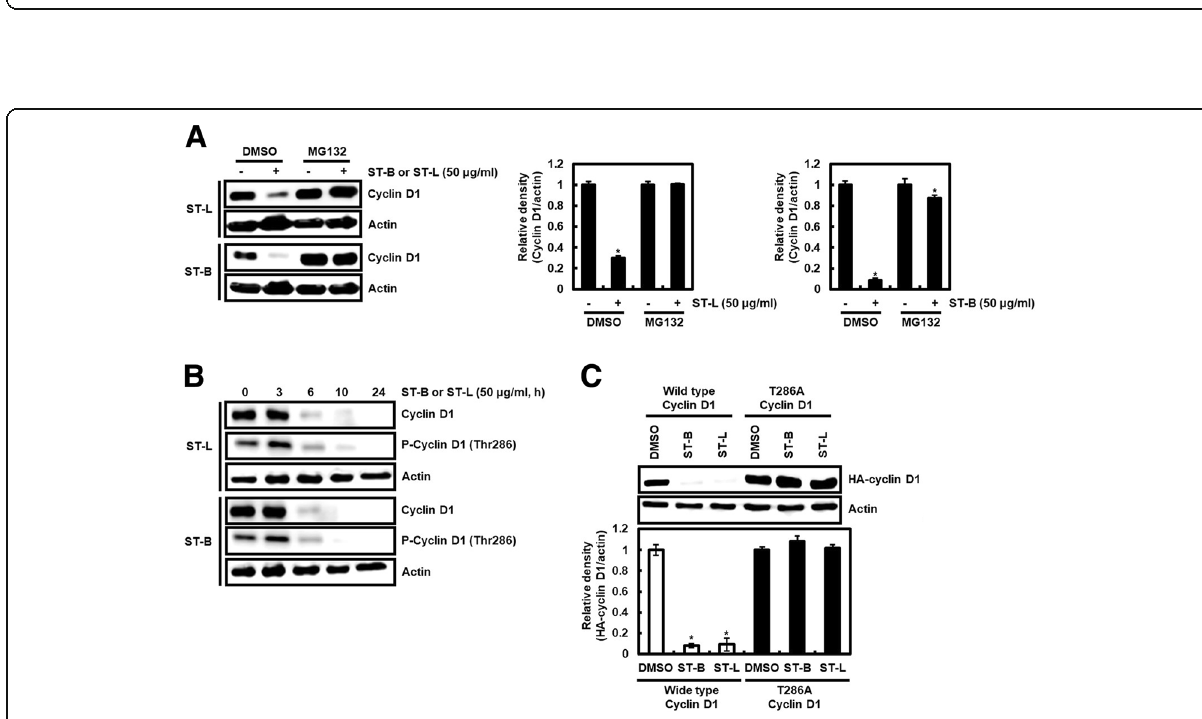
Fig. 2 Induction of cyclin D1 degradation by STL and STB through Thr286 phosphorylation of cyclin D1. a SW480 cells were pretreated with MG132 (20 μ M) and then co-treated with STL and STB for additional 6 h. b SW480 cells were treated with STL and STB for the indicated times. ( c ) SW480 cells were transfected with HA-tagged wild type cyclin D1 construct or HA-tagged T286A cyclin D1 construct for 48 h, and then co- treated with STL and STB for the additional 6 h. Actin was used as loading control. * P < 0.05 compared to the cells without STL and